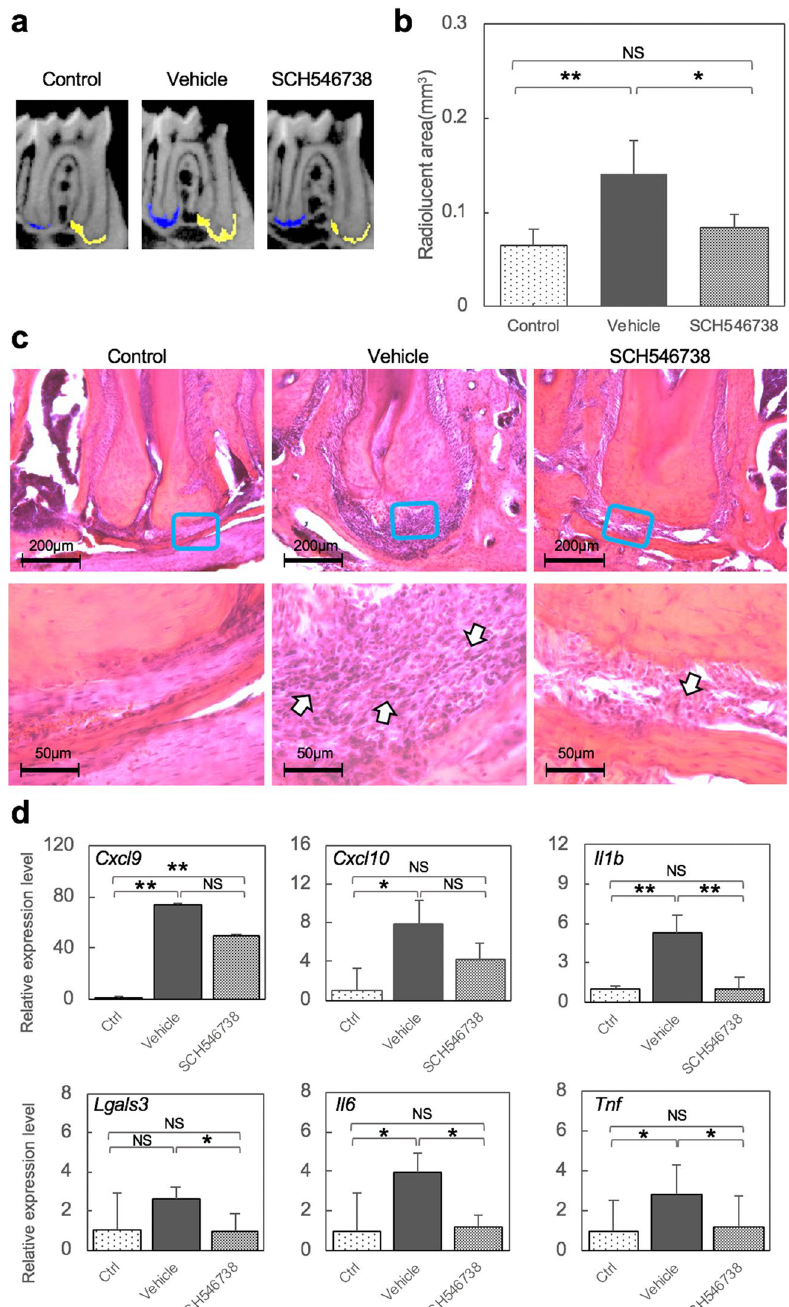
Figure 3. An orally administered CXCR3 antagonist suppresses periapical lesion formation. ( a ) Representative μCT images of the AP mouse at 28 days after pulp exposure. The radiolucent area is indicated by yellow and blue colors, determined using TRI/3D-BON software based on the CT values. ( b ) Quantitative analysis of the radiolucent area (mm 3 ) from the μCT images. Statistical analysis was conducted using the Turkey-Kramer test; *p < 0.05, **p < 0.01 (mean ± SD, n = 5 per group). ( c ) HE staining around the periapical area at 28 days after pulp exposure. The arrow highlights inflammatory cell filtration. ( d ) Validation of the inflammatory markers by quantitative PCR analysis. Statistical analysis was conducted using the Turkey-Kramer test; *p < 0.05, **p < 0.01 (mean ± SD, n = 4 per